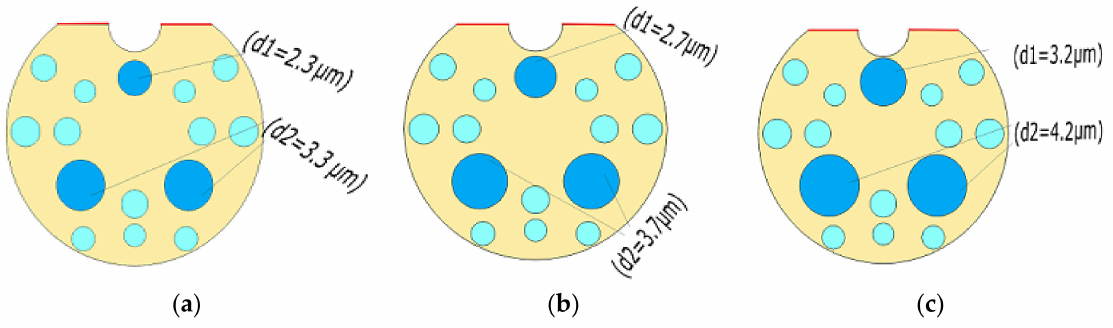
Figure 3. D-shaped PCF based polarization filter with different air hole’s sizes ( a ) air holes dia d1 = 2.3 µ m and d2 = 3.3 µ m (high lattice) ( b ) air holes dia d1 = 2.7 µ m and d2 = 3.7 µ m (Mid lattice) ( c ) air holes dia d1 = 3.2 µ m and d2 = 4.2 µ m (low